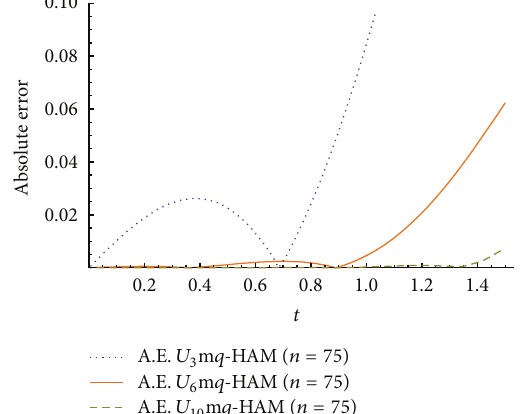
Figure6:Thecomparisonbetweenthe 𝑈 3 , 𝑈 6 ,and 𝑈 10 of m 𝑞 -HAM (𝑛 = 75) and the exact solution of (28) at ℎ = −49.25 and 𝑥 = 1 .